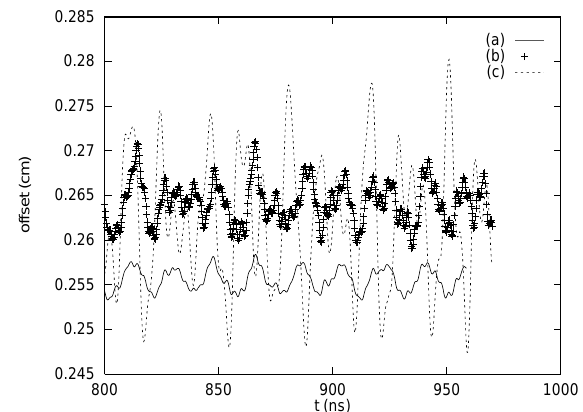
FIG. 11. Comparison of transverse oscillations for (a) 5 k V resistor, e (cid:1) 2.3 oil; (b) no resistor, e (cid:1) 2.3 oil; (c) no resistor and e (cid:1) 1 oil.